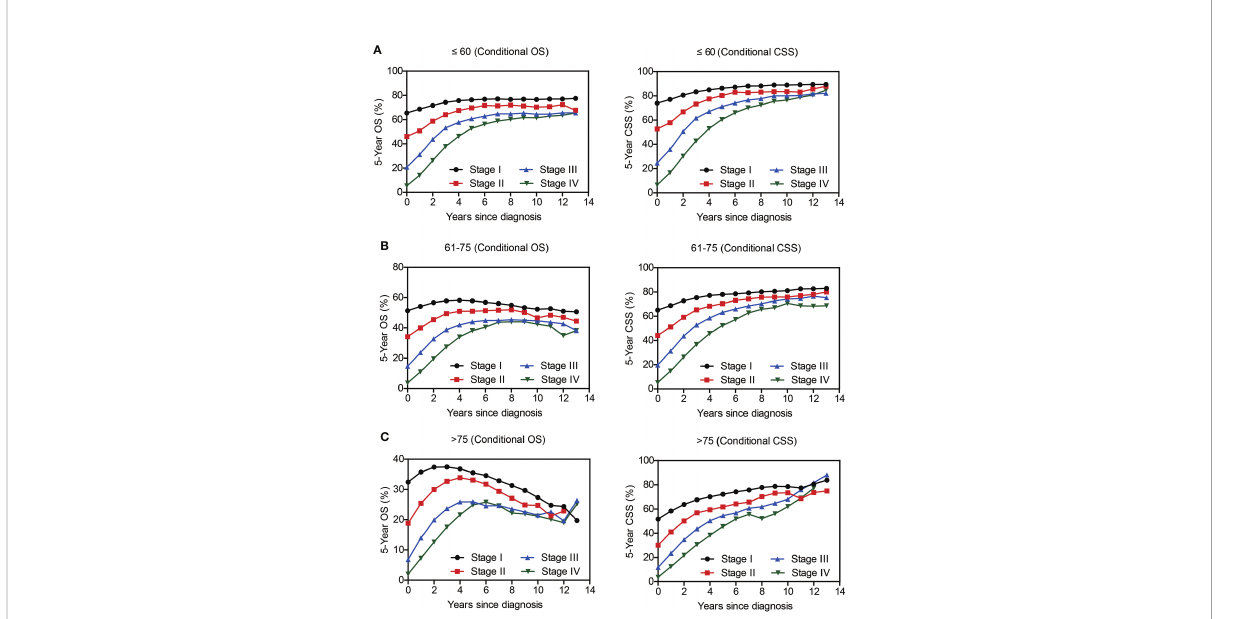
FIGURE 3 The 5-year conditional survival rate of lung cancer as per the TNM Stage and Age. Subgroup analyses of 5-year conditional survival rate based on patients ’ TNM stage of those aging ≤ 60 yrs (A) , 61-75 yrs (B) , or > 75 yrs (C) .